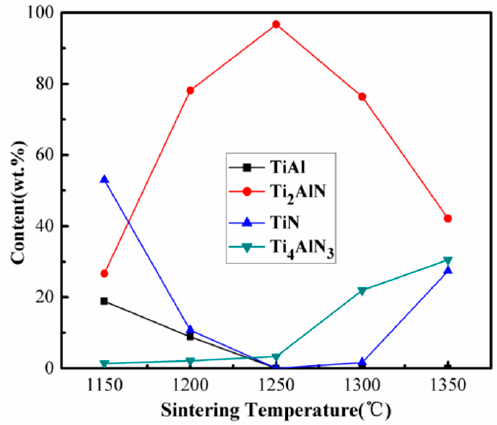
Figure 6. XRD patterns of the 1TiH 2 /1.15Al/1TiN powder system after 30 min of sintering at different temperatures (1150–1350 °C): ( a ) 1150 °C; ( b ) 1200 °C; ( c ) 1250 °C; ( d ) 1300 °C; ( e ) 1350 °C.